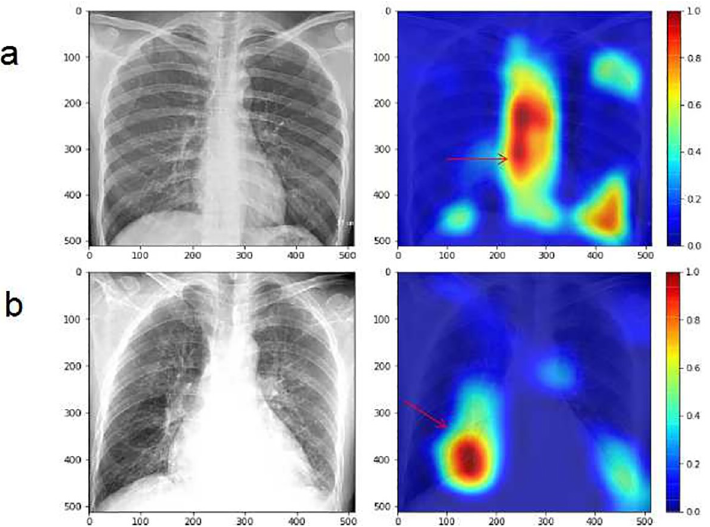
Fig 6. Visualization of CNN models using Grad-CAM to classify PH from normal based on radiograph images. The highlighted areas indicatied by red arrows are discriminative features for identification of PH. The Grad-CAM of patient without PH (a). The Grad-CAM of patient with PH (with PASP of 56mmHg) (b). CNN, Convolutional Neural Network; PH, pulmonary hypertension; Grad-CAM, Gradient Class Activation Map; PASP, pulmonary artery systolic